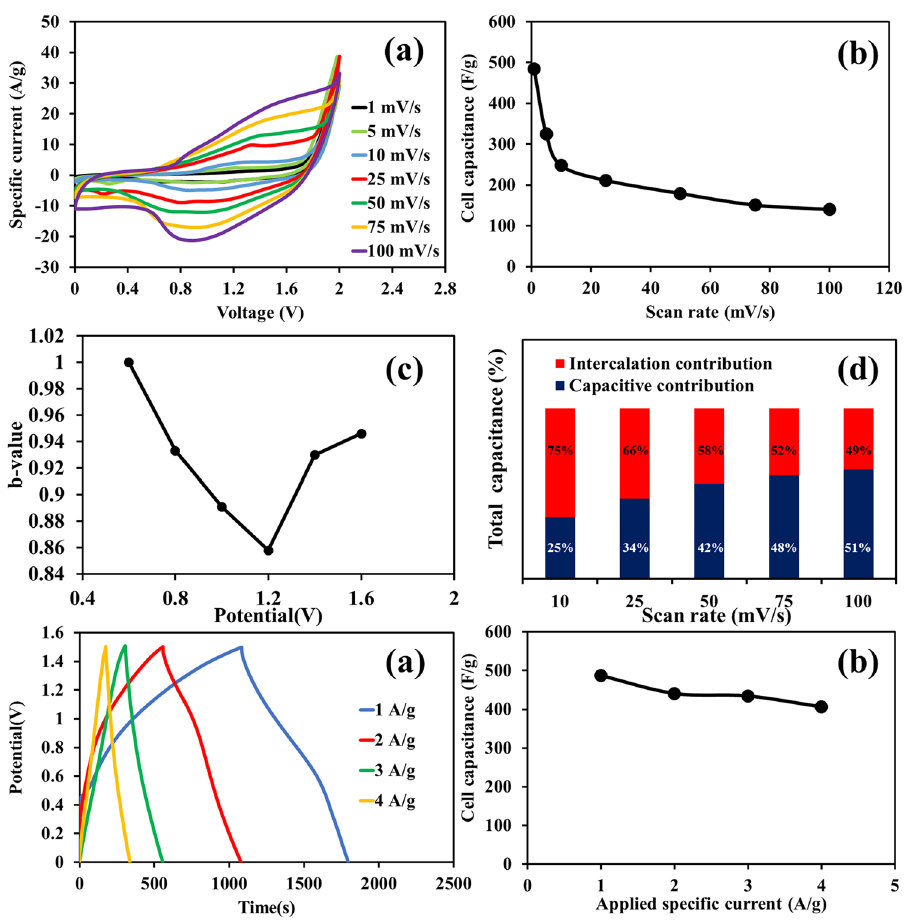
Figure 4. ( a ) CV curves at different scan rates, ( b ) specific capacitance vs. scan rate, ( c ) b -value vs. potential (V), ( d ) total capacitances at different scan rates, ( e ) GCD curves and ( f ) specific capacitance vs. applied currents of the Ni(OH) 2 -N-rGO ae //N-rGO ae AES. Note, the total active material of the device is 4.0 mg consisting of 1.47 mg of Ni(OH) 2 -N-rGO ae at the positive electrode and 2.53 mg of N-rGO ae at the negative